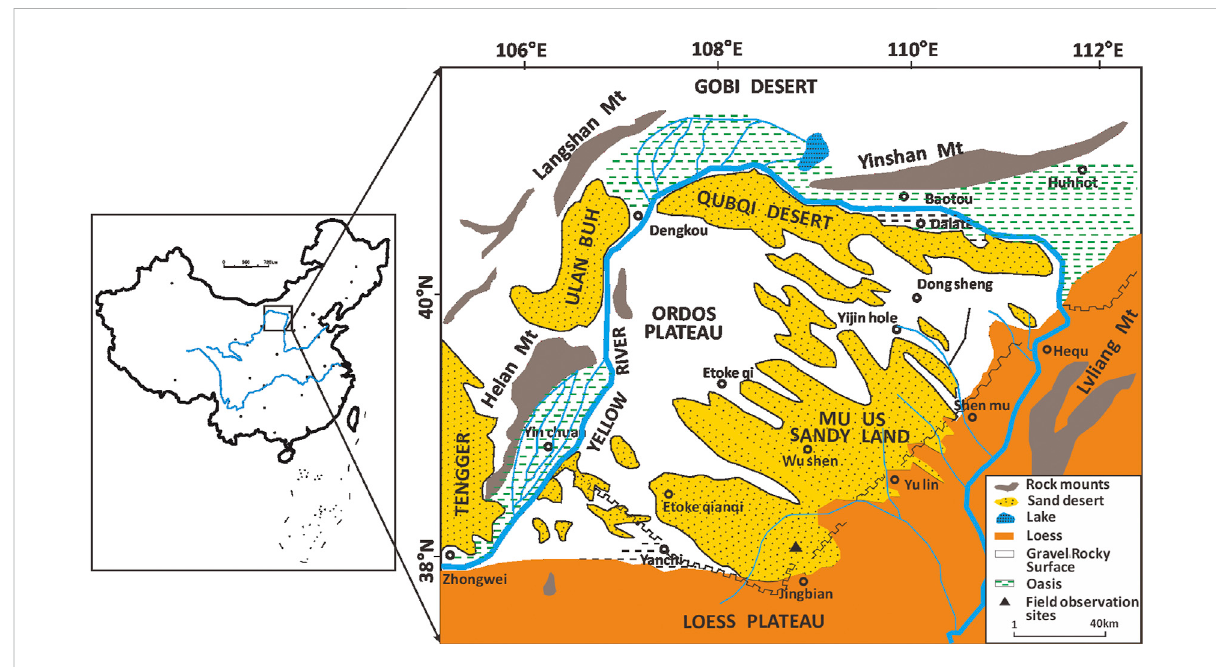
FIGURE 1 Location of the study area on the southern fringe of the Mu Us Sandy land, China (37 ° 38 ′ 42 ” ~37 ° 47 ′ 54 ″ N, 108 ° 50 ′ 54 ” ~108 ° 58 ′ 00 ″